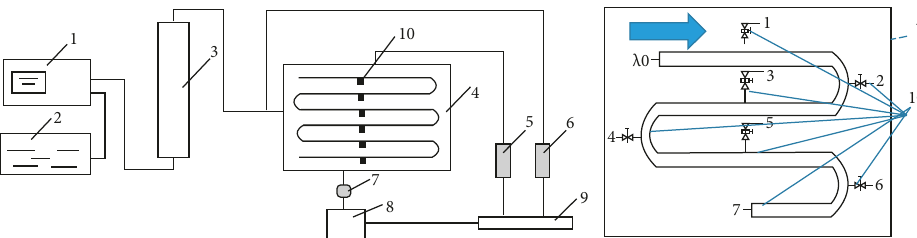
Figure 1: Emulsification experimental apparatus based on a long core. 1, ISCO pump; 2, simulated water; 3, intermediate container; 4, the physical model; 5, 6, and 7, pressure sensors; 8, computer; 9, data acquisition system; 10 sampling points. Table 1: Parameters of sand packed core.